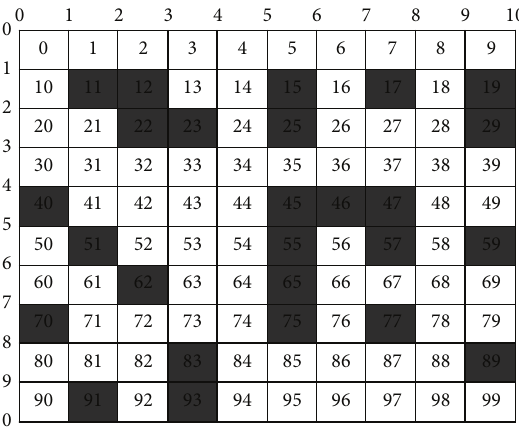
Figure 1: Environment